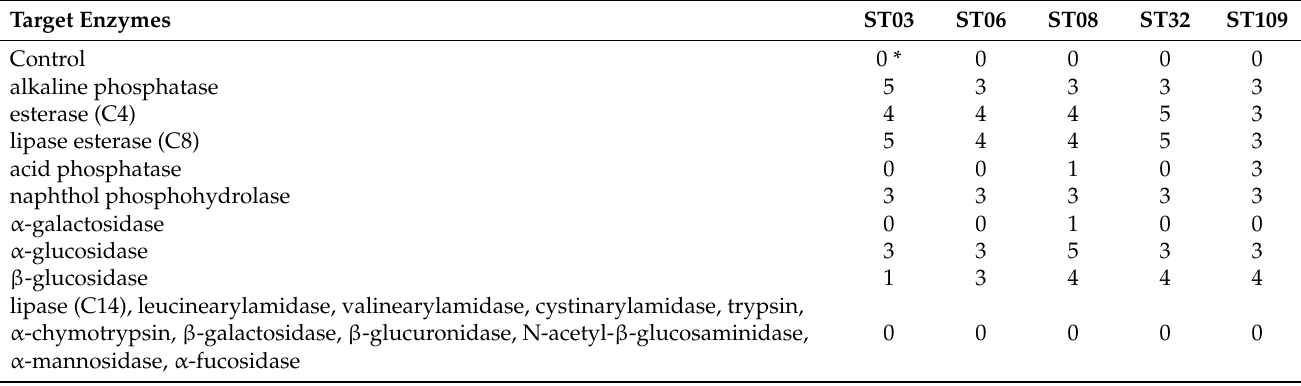
Table 3. Enzyme production profile recorded for B. velezensis ST03, B. amyloliquefaciens ST06, B. subtilis ST08, B. velezensis ST32, and B. amyloliquefaciens ST109 based on APIZym (BioMerieux). Target Enzymes ST03 Control alkaline